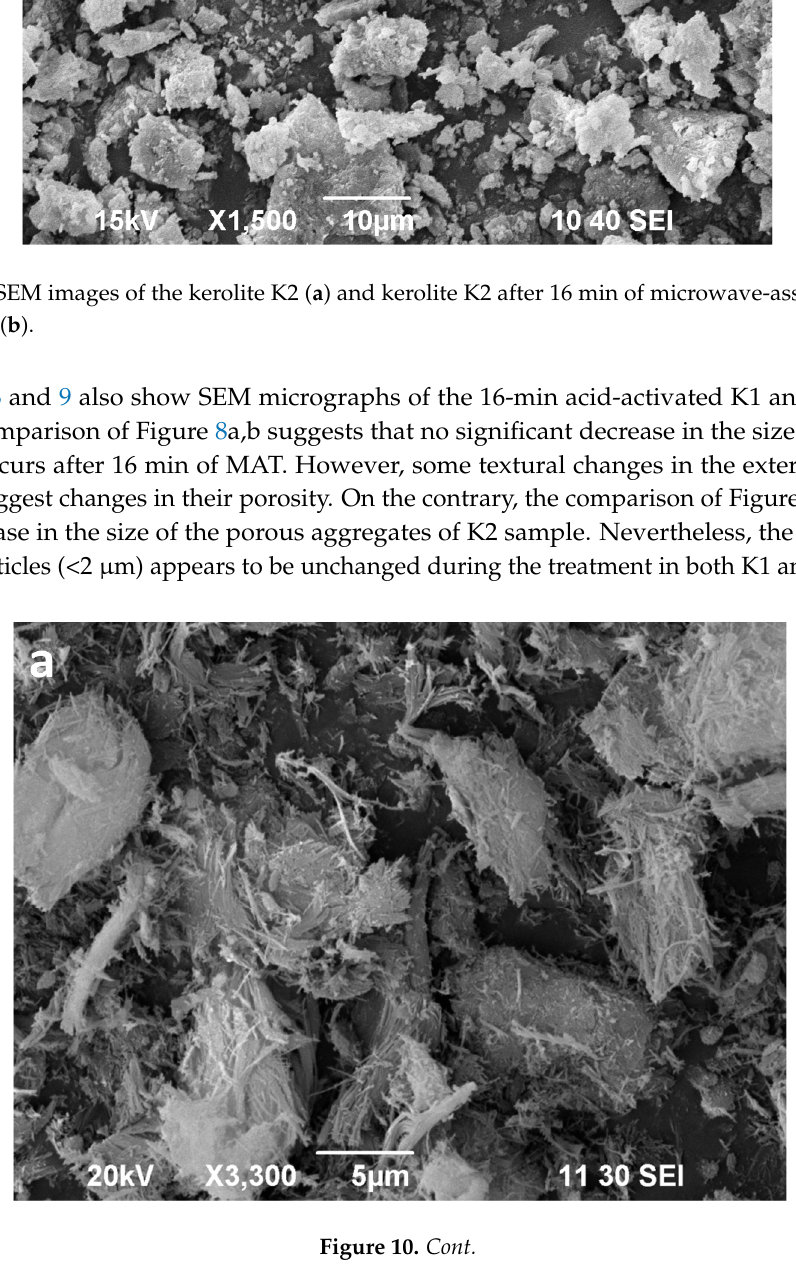
Figure 9. SEM images of the kerolite K2 ( a ) and kerolite K2 after 16 min of microwave-assisted acid treatment ( b ).